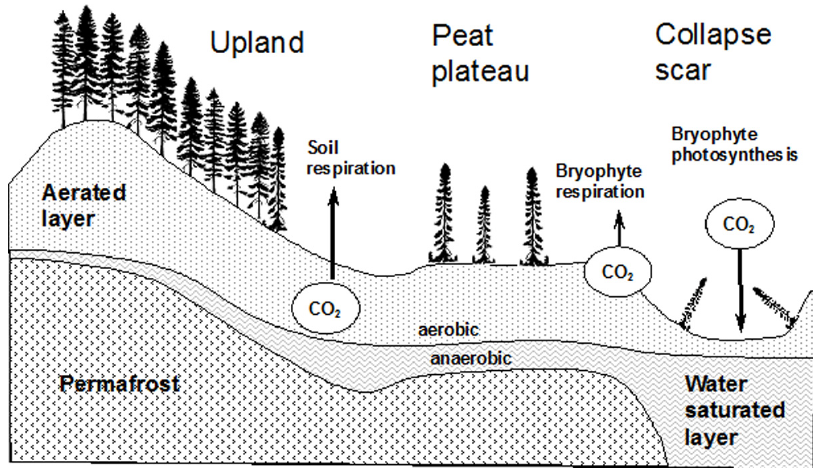
Figure 2. Schematic of the site landform features and key fluxes of CO 2 . The arrows only represent the major fluxes not their magnitude at any point in time.